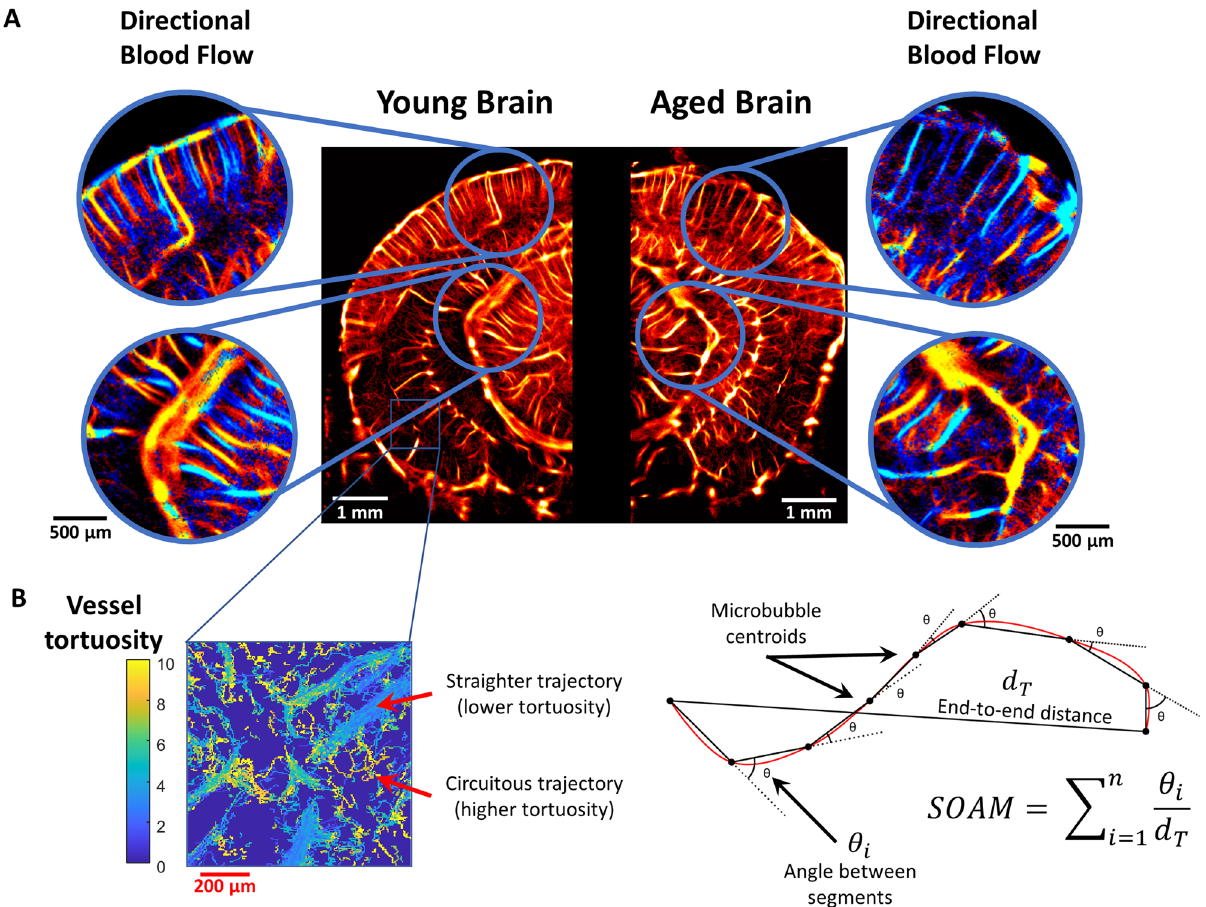
Figure 3. ULM imaging of young and aged mouse brain. ( A ) Example ULM microvessel density maps images from a (left) young mouse brain and (right) an aged mouse brain. Local cortical and subcortical regions are selected and magnified to show the corresponding directional blood flow maps (blue toward the transducer, red away from the transducer). ( B ) An inset image demonstrating distinct vessel tortuosity phenotypes. The larger, straighter vessels have a relatively low measured tortuosity, whereas the smaller connecting vessels are more circuitous. A diagrammatic example of how the sum of angles metric was determined using the microbubble trajectory data. For each complete microbubble trajectory the total path length, end-to-end distance, and angle between every segment was used in the calculation. ULM images were rendered using MATLAB (R2019a, https:// www. mathw orks.